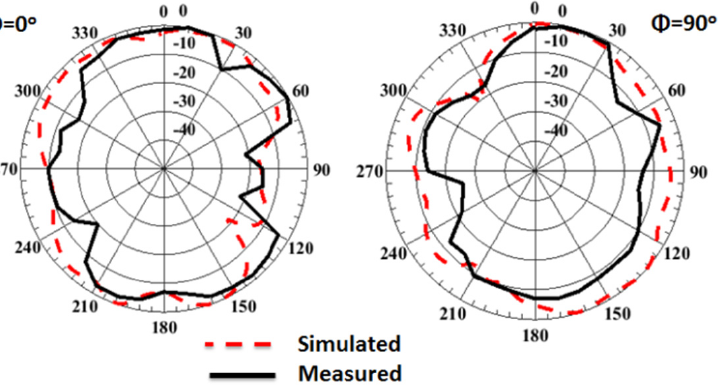
Figure 14. The normalized radiation patterns outcomes of 4-port MIMO antenna at port 1 and 38 GHz.